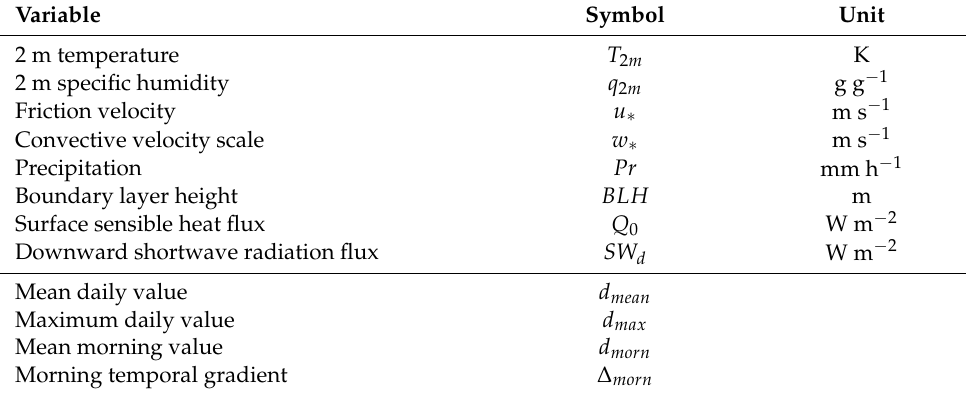
Table 3. Meteorological variables used for the correlation calculations to the ragweed pollen concen- trations. For the “morning” values, d morn , the average and the difference are calculated using the hourly data between 03:00 UTC and 12:00